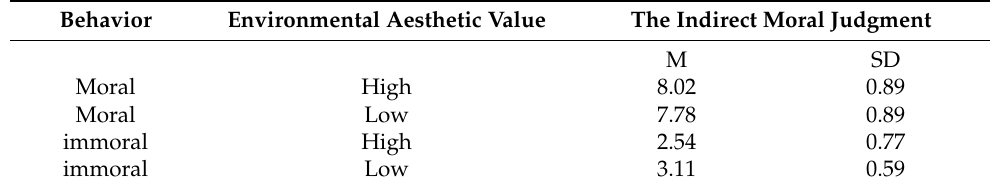
Table 7. Mean rating scores of moral judgments in different environments (M ± SD) in Experiment 2b.